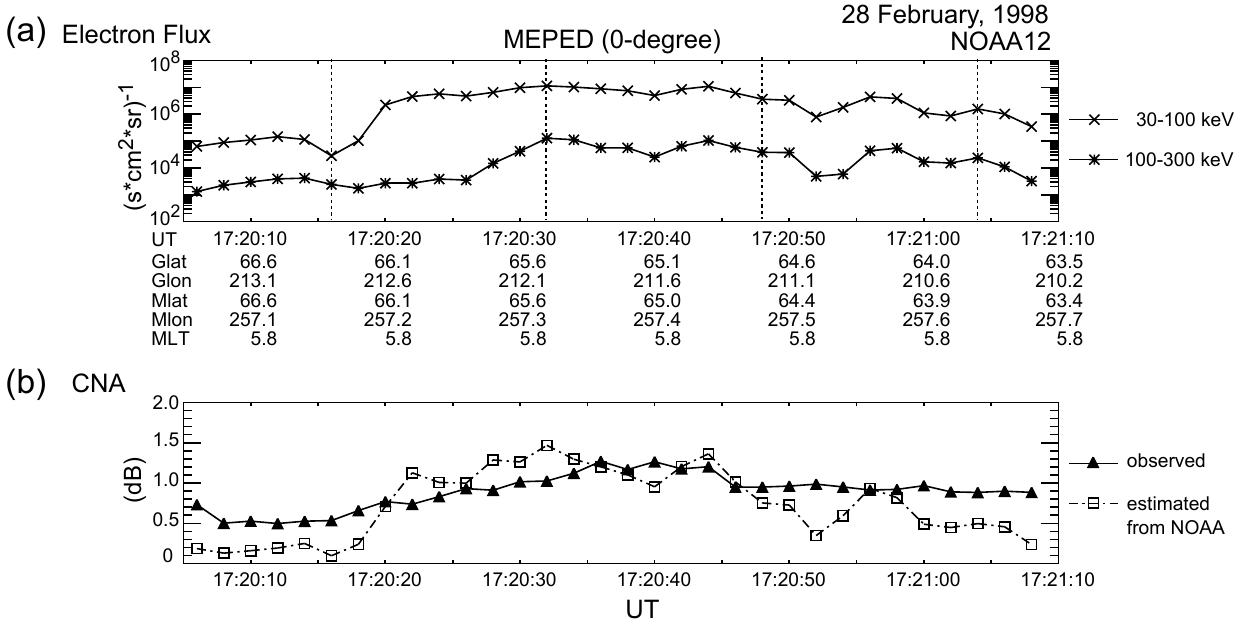
Fig. 2. (a) Electron flux measured at 0 ◦ zenith angle by the MEPED on board NOAA 12 for the event shown in Fig. 1. (b) CNA observed with the imaging riometer on the beam closest to the satellite footprint at 90km (solid triangles with the solid line) and the CNA estimated from the precipitating electron flux measured by the TED and MEPED (open squares with the dashed-and-dotted